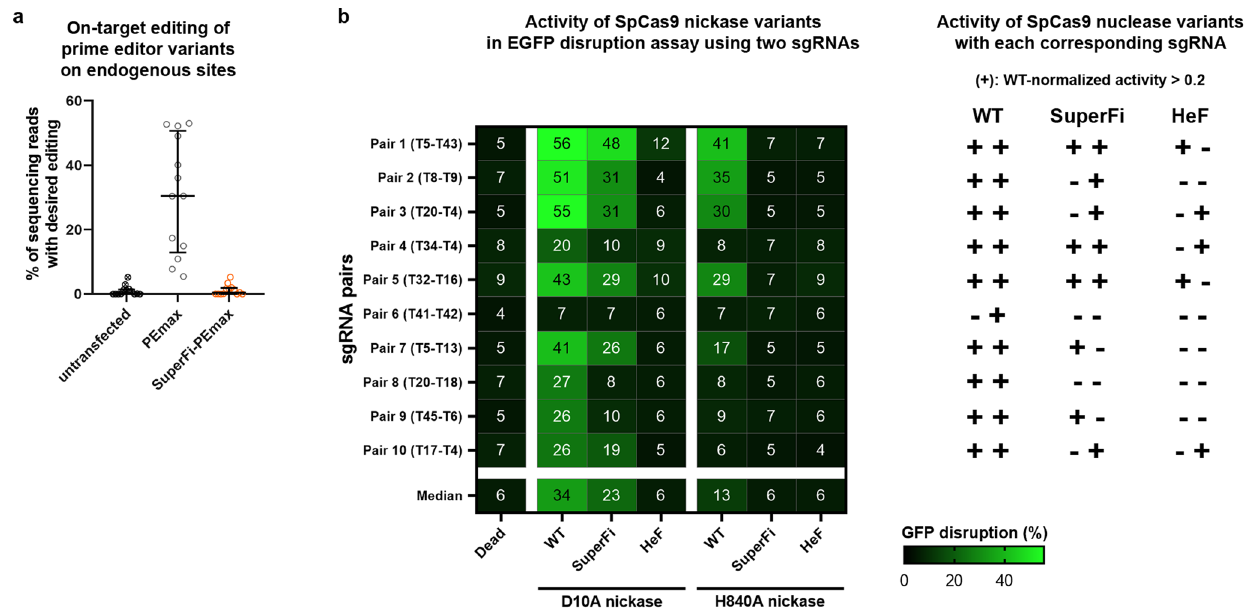
b (left) On-target disruption activities of nickase SpCas9 variants with paired sgRNAs. The heatmap shows the mean on-target modi fi cations (indels) of three parallel transfections. (right) +/ − indicate the activity of the nuclease variants with the corresponding sgRNAs. a , b Summary of target and primer sequences, EGFP disruption and NGS data are reported in Supplementary Data 1 –